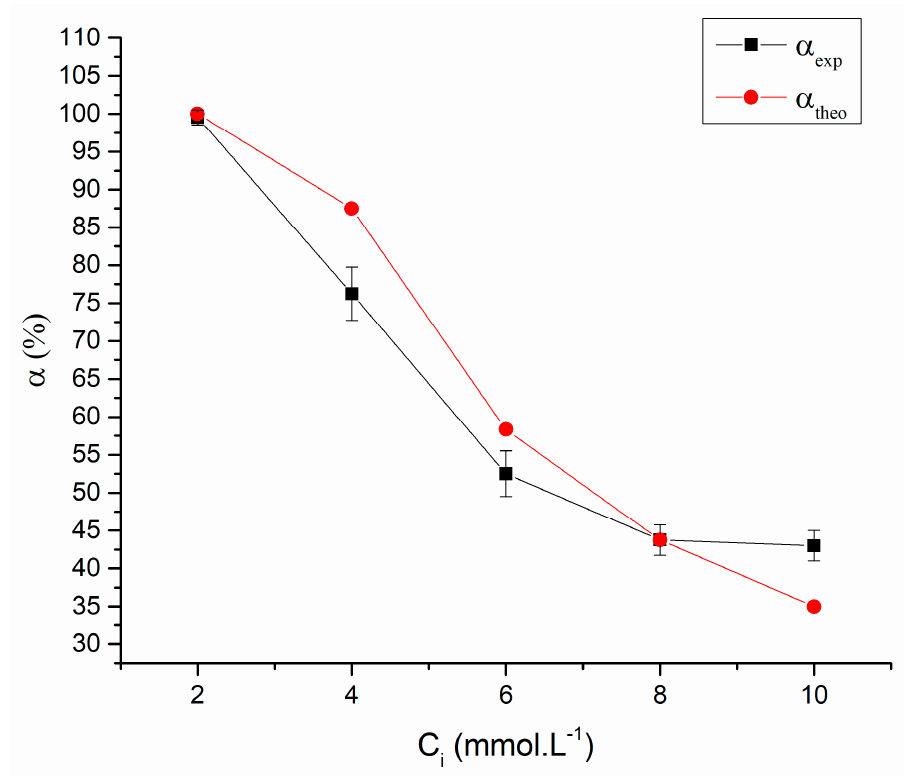
Figure 10. The removal efficiency ( ■ ) and the theoretical one ( ● ) of Eu 3+ ions ( α ) by poly(VDF- ter - VPA- ter -VTEOS) terpolymer ( HCP 20 ) versus their initial concentration (from Equations (3)–(6)).